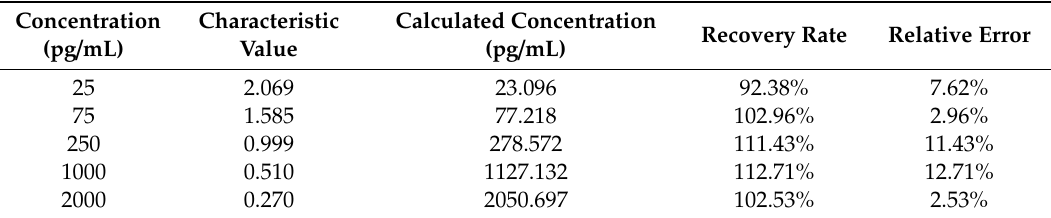
Table 2. Test results for AFB1.